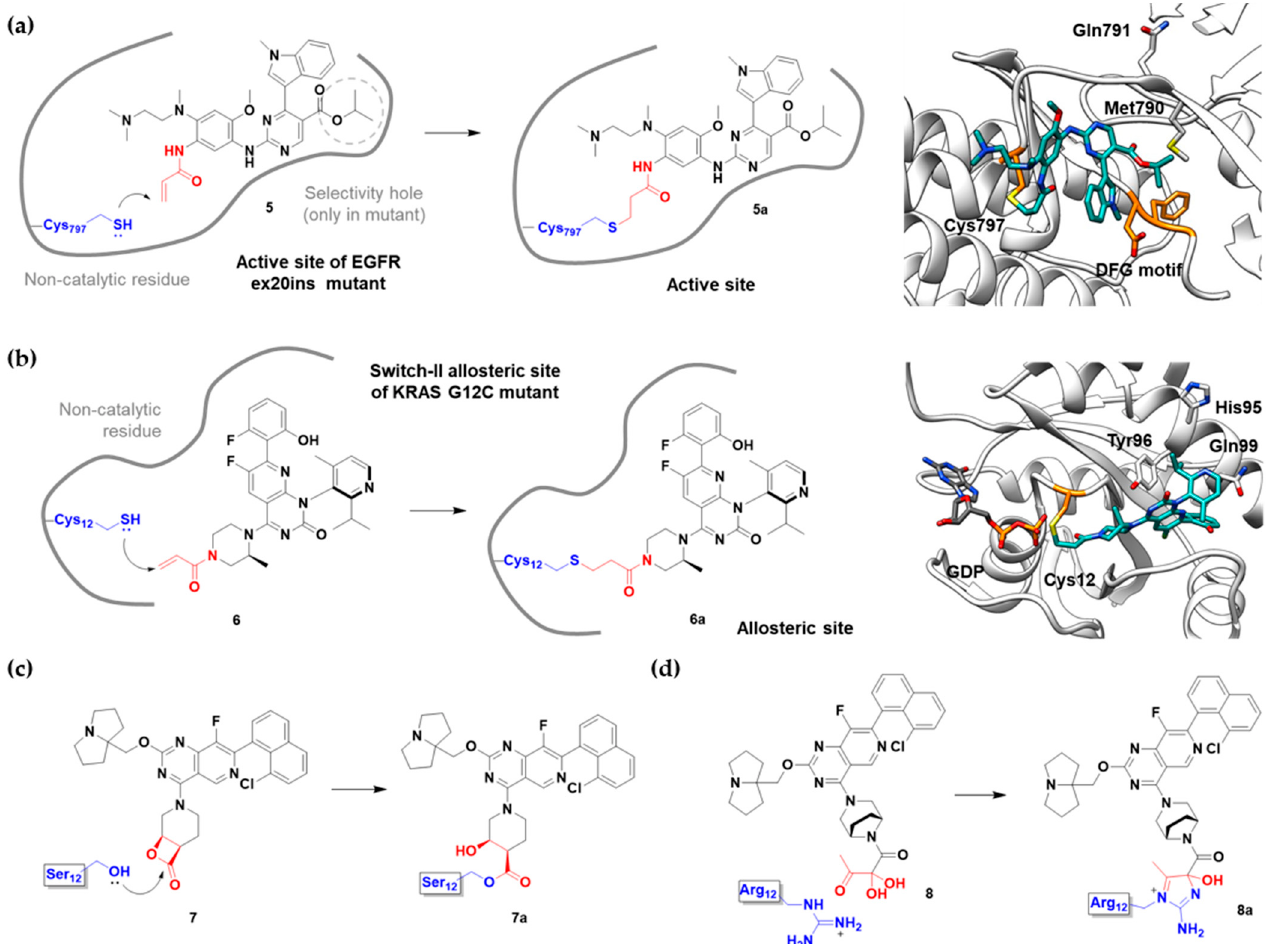
Figure 4. Representative examples of targeted covalent inhibitors: ( a ) schematic diagram and co-crystal structure of EGFR ex20ins mutant with covalent inhibitor 5 (mobocertinib) (PDB: 7A6K). Mobocertinib is bound to the non-catalytic cysteine residue of the kinase active site. Mechanism of the reaction between cysteine and acrylamide warhead of mobocertinib generating β -thiopropanamide adduct 5a is shown. Only mutant kinase, which has a selectivity hole in contrast to wild-type, can accommodate the bulky isopropyl group of mobocertinib; ( b ) schematic diagram and co-crystal structure of KRAS G12C mutant with covalent inhibitor 6 (sotorasib) (PDB: 6OIM). Sotorasib is bound to the non-catalytic residue at the kinase allosteric site, switch-II pocket. Mechanism of the reaction between cysteine and acrylamide warhead of sotorasib generating β -thiopropanamide adduct 6a is shown. The cysteine residue only present in the mutant confers the selectivity; ( c ) mechanism of the reaction between serine and lactone warhead of the covalent inhibitor 7 generating ester adduct 7a ; ( d ) mechanism of the reaction between arginine and α , β -diketoamide warhead of the covalent inhibitor 8 generating 4H-imidazolium adduct 8a